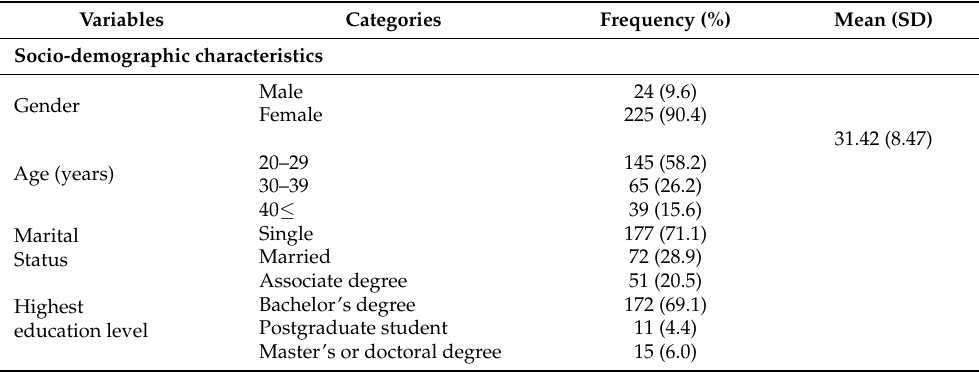
Table 1. General Characteristics of the Participants (N =